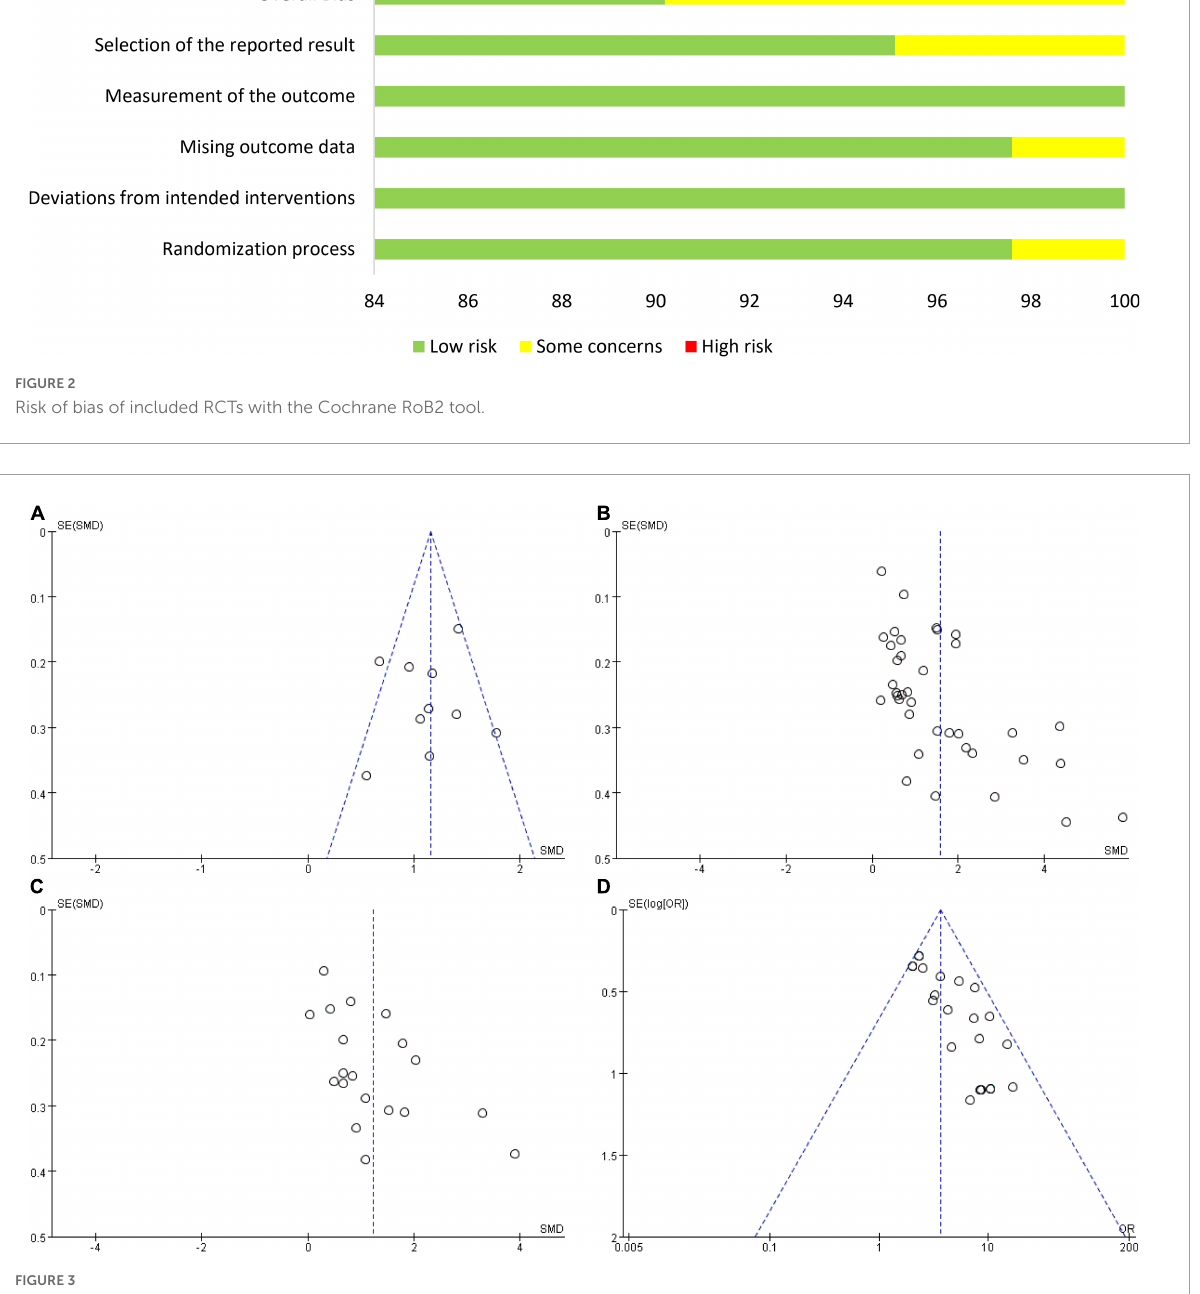
90.2%) had low attrition bias, four studies (9.8%) had some unclear risk of bias due to insufficient information on